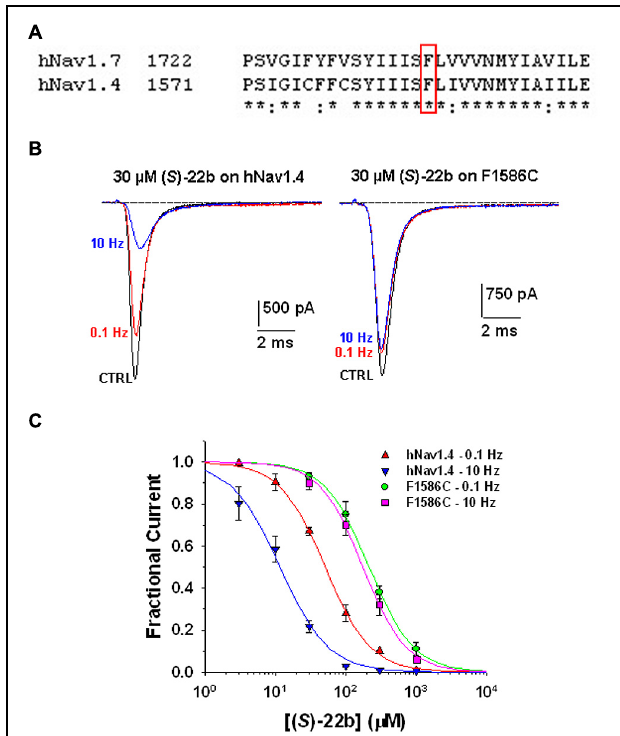
FIGURE 5 | Effects of ( S )-22b on wild-type hNav1.4 channels and F1586C mutant. (A) Amino acid alignment of hNav1.7 and hNav1.4 using Clustal W 2.0 shows high conservation of the putative local anesthetic receptor located within the sixth segment of domain IV. The phenylalanine residue in red box (F1586 in hNav1.4 and F1737 in hnav1.7) is thought to be critical for the binding of local anesthetics to inactivated sodium channels. (B) Representative traces of sodium currents recorded as in Figure 2 in HEK29 cells permanently transfected with wild-type hNav1.4 or F1586C hNav1.4 mutant. The inhibitory effects of 30 µ M ( S )-22b were greatly reduced in the F1586C mutant. (C) Concentration–response relationships for ( S )-22b at 0.1 and 10 Hz stimulation frequencies were obtained as in Figure 3 , and fitted with Eq. 1. Each data point is the mean ± SEM of at least three cells. At both stimulation frequencies, the inhibition of F1586C channels by ( S )-22b was significantly minor with respect to that of WT channels at 30, 100, 300, and 1000 µ M (at least P < 0.05 with unpaired Student’s t -test). The fit parameters together with the SE of the regression are given in Table 1 .